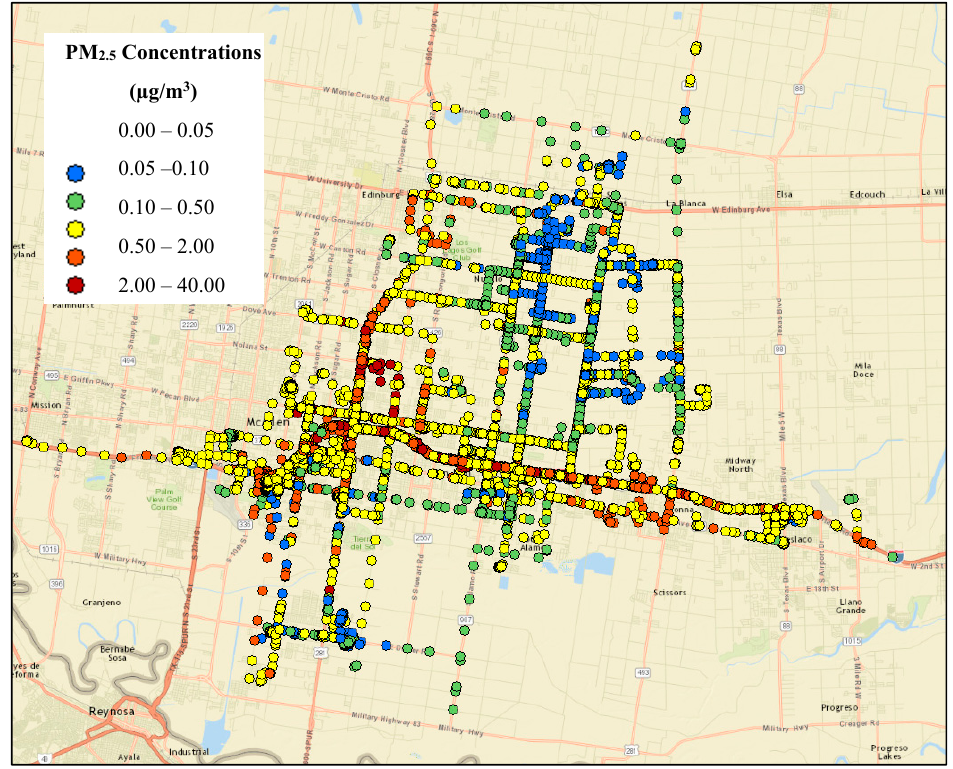
Figure 7. The tra ffi c-related PM 2.5 mass concentration ( µ g / m 3 ) modeled by AERMOD as a function of Figure 7. The traffic-related PM 2.5 mass concentration (µg/m 3 ) modeled by AERMOD as a function of time and GPS coordinates for all 17 participants. time and GPS coordinates for all 17 participants. Tra ffi c-related PM 2.5 concentration ( µ g / m 3 ) in three microenvironments over the 50 measurement